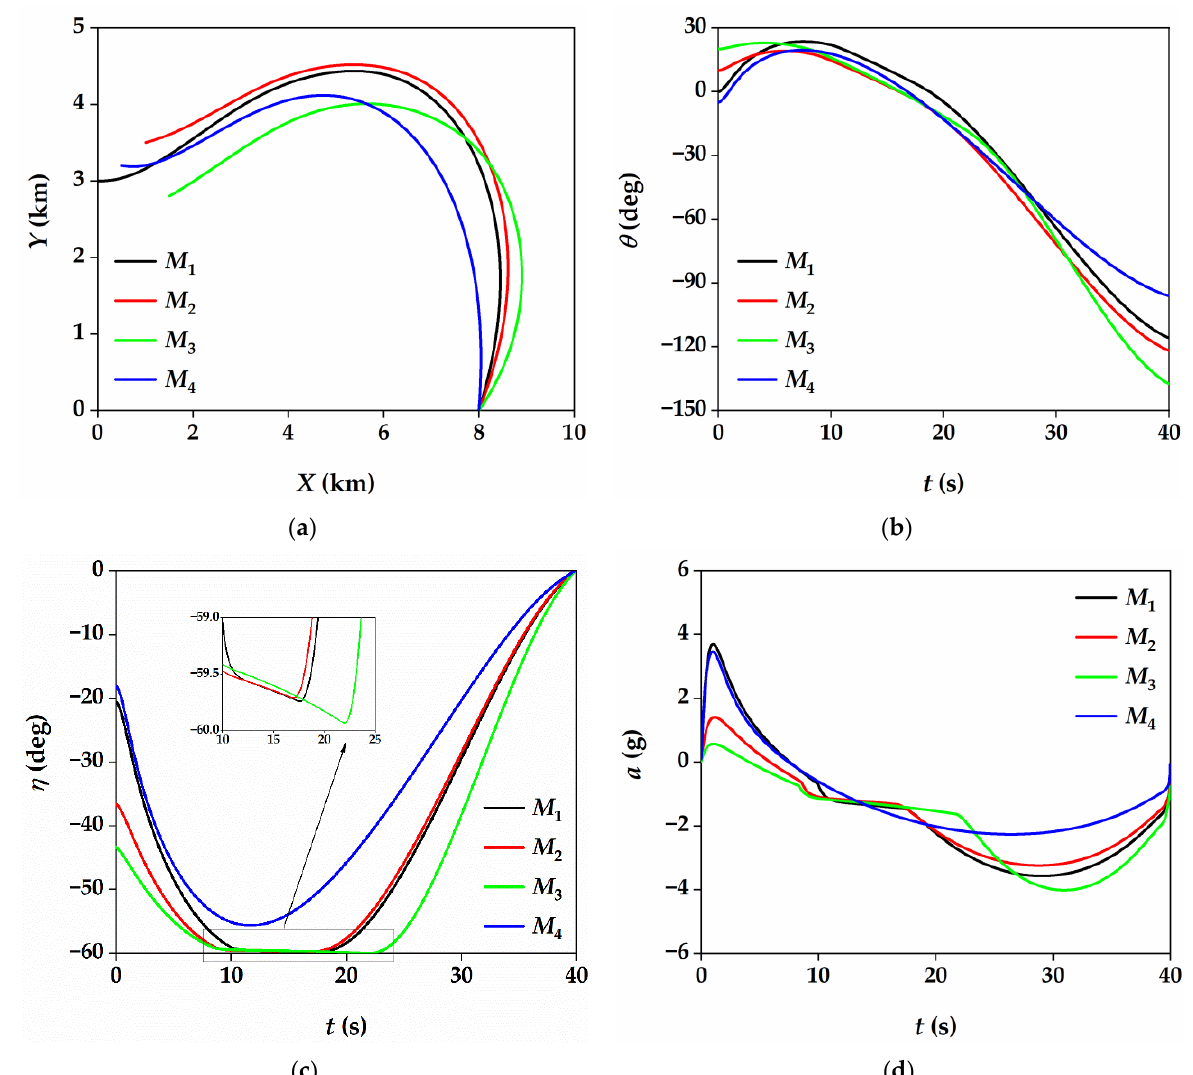
Figure 7. Simulation results of a 4 missile salvo attack. ( a ) Missile flight trajectory ; ( b ) Flight path angle ; ( c ) Lead angle ; ( d ) Missile achieved acceleration.